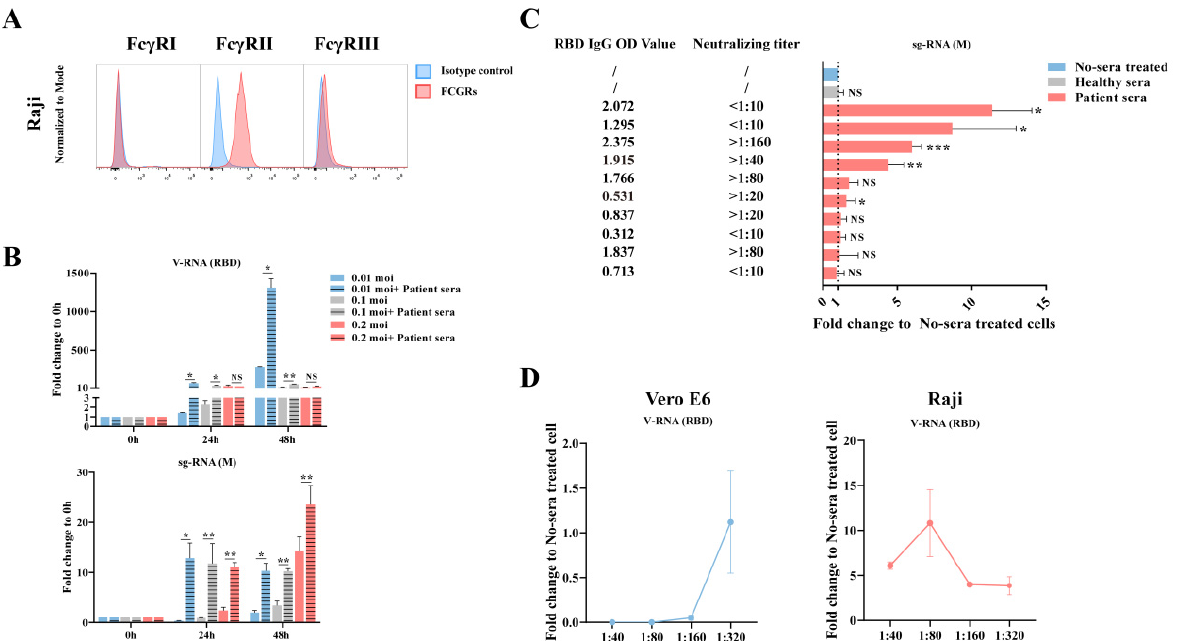
Figure 2. Factors related to ADE effect. ( A ) The expression of Fc γ Rs in Raji B cells, a cloned immortalized cell line. ( B ) Raji B cells were infected with SARS-CoV-2 at a moi of 0.01, 0.1, and 0.2 with or without convalescent sera. Samples were harvested at 0 h, 24 h, or 48 h post infection and cellular viral load was then quantified by qRT-PCR detection of total viral RNA or subgenomic RNA (sgRNA). ( C ) SARS-CoV-2 virus pretreated with equal-volume convalescent sera from different COVID-19 patients (1:40 of final dilution) or RPMI1640 at 37 ◦ C for 30 min. Viral mixtures were added to Raji B cells at a moi of 0.1. Samples were harvested at 48 h post infection and cellular viral load was then quantified by qRT-PCR detection of sgRNA. RBD IgG OD value and neutralizing titer of convalescent sera were quantified by ELISA or micro-neutralization assay, respectively. ( D ) Convalescent serum from one COVID-19 patient was diluted to 1:40, 1:80, 1:160, and 1:320. SARS-CoV-2 was pre-incubated with equal-volume sera at 37 ◦ C for 30 min and then added to Vero E6 or Raji B cells at a moi of 0.1. Samples were harvested at 48 h post infection and cellular viral load was then quantified by qRT-PCR detection of viral RBD. The Vero E6 detection data can be found in Supplementary Figure S1B. Comparison between different sample groups was analyzed by the Student’s t -test. * p <0.05; ** p < 0.01; *** p < 0.001; NS, no significance. The short lines mean to compare viral load in infected cells with or without patient